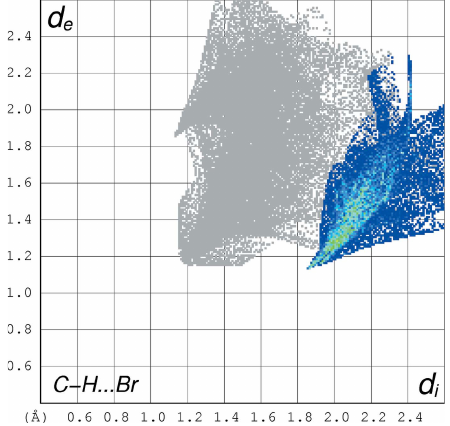
Figure 4 Hirshfeld surface plot highlighting the C—H (cid:3)(cid:3)(cid:3) Br interactions, which make up 52.6% of all interactions.